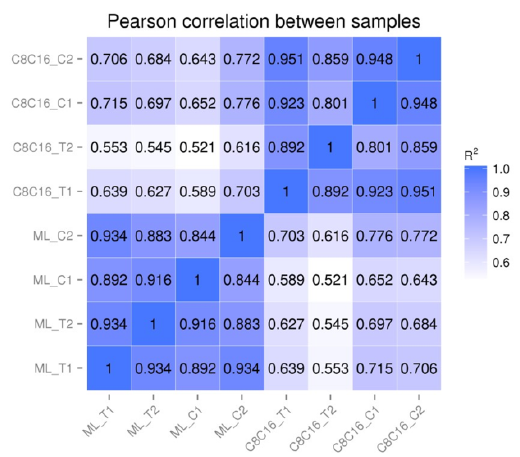
Figure 1. Heat map of bovine embryo biological replicates at the 8-16-cell or morula stage. Duplicate in vitro-fertilized bovine embryos were treated with GSH or not for 7 days, then lysed at the 8-16-cell or morula stage for RNA extraction and sequencing. The Pearson correlation coefficient was used to measure reproducibility of sample preparation and sequencing results. The blue to white color spectrum represents correlation coefficients ranging from 1 to 0.553, indicating high to low